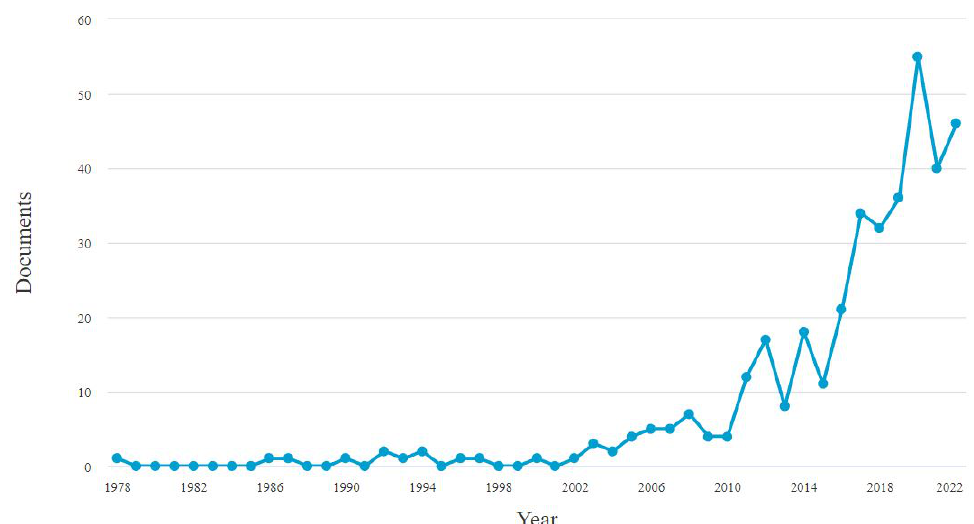
Figure 2. Related publications per